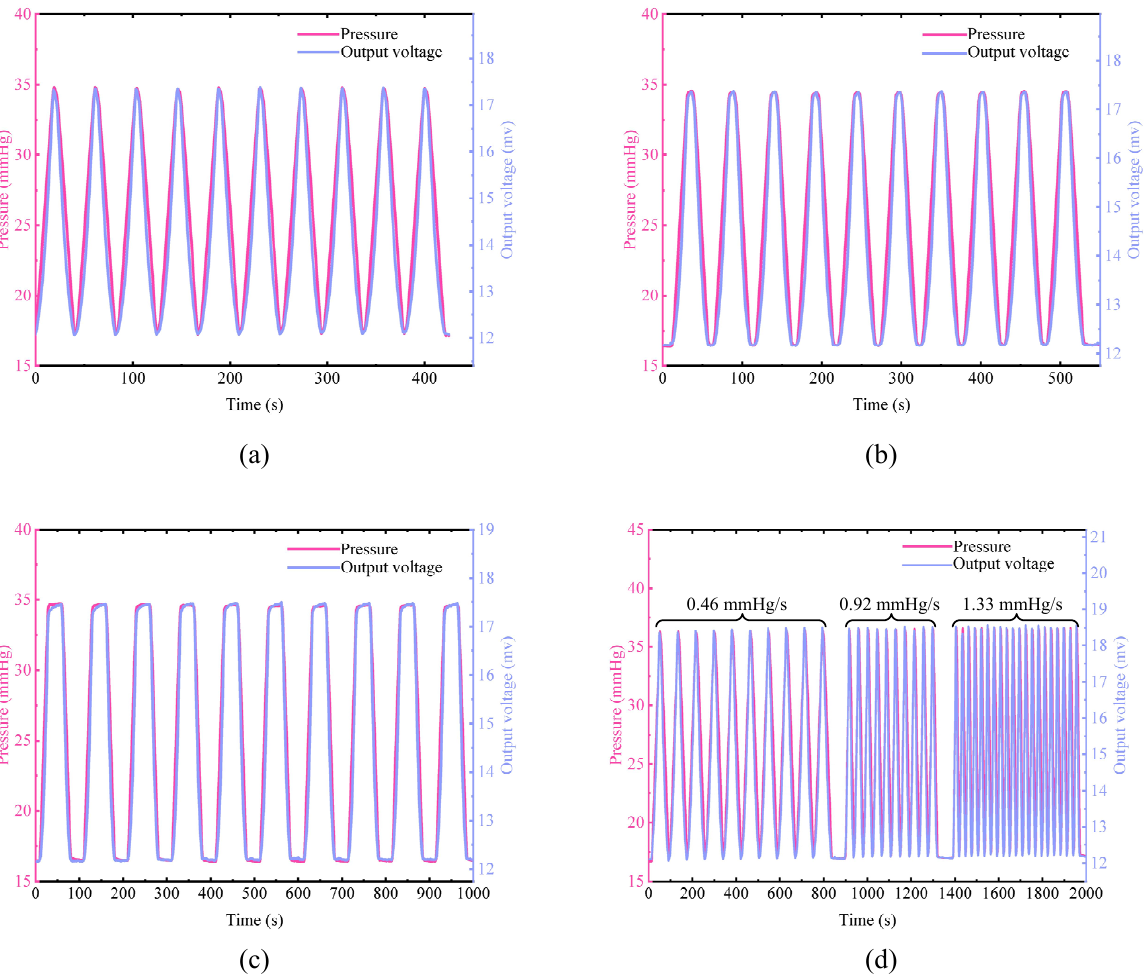
Figure 6. Dynamic performance of a contact lens sensor on the eyeball model. ( a – c ) The dynamic cyclic performance of the sensor under different pressures when staying for 0 s, 6 s, and 30 s at the peak, respectively. ( d ) The dynamic cycle performance of the sensor at different speeds of IOP variation.